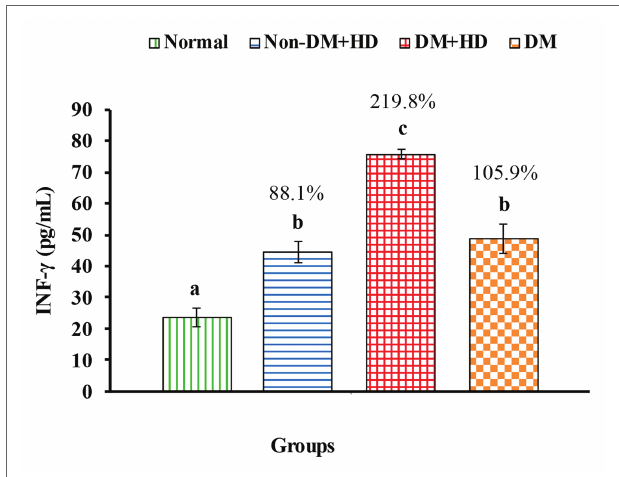
FIGURE 2 | The level of interferon gamma [IFN- γ (pg/mL)] in the blood of non-diabetic and diabetic patients with or without kidney failure. Means, which have different superscript letters, are significantly different at p < 0.05. Percentage changes were calculated in comparison with normal group. Value of p :